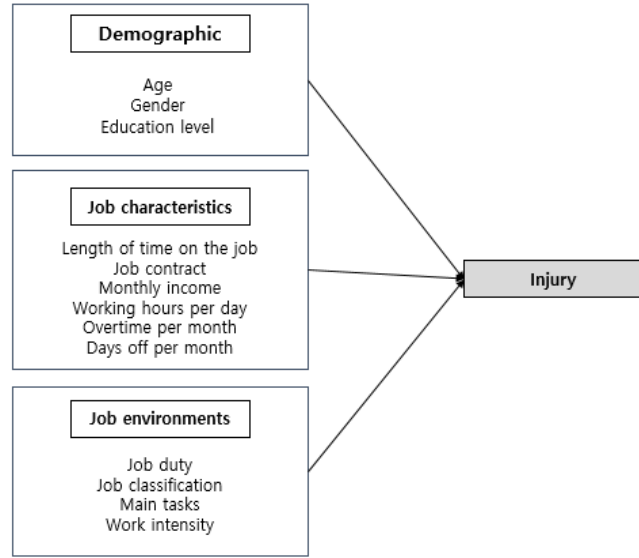
Figure 1. Conceptual model of occupational Figure 1 . Conceptual model of occupational injuries.